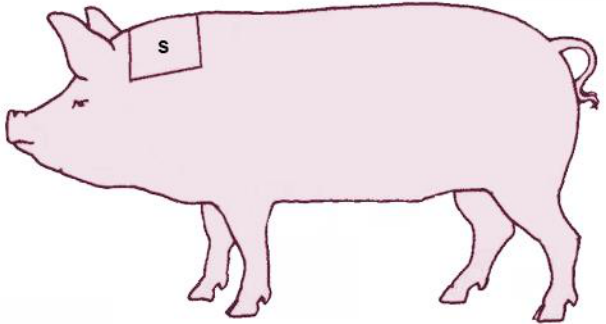
Figure 3. Localization of the shaving area between neck and shoulder in sows. Hair samples were stored in polypropylene tubes (Falcon, Fisher Scientific, Rodano, Milan, Italy) at room temperature until analysis. Extraction of hair cortisol was performed following the procedure described by Burnett et al. [29,30]. A 100 mg hair sample from each sow was washed twice with double-distilled water and allowed to dry